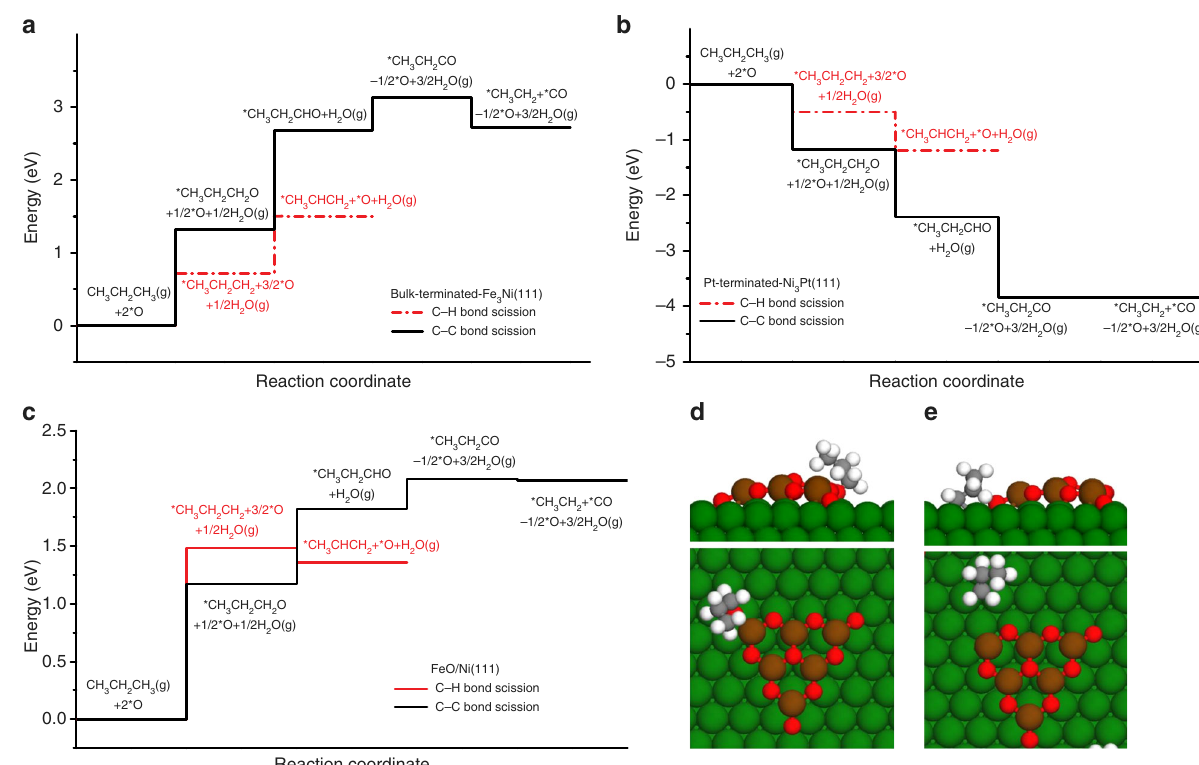
Fig. 4 DFT calculated energy pro fi les for the oxidative C – H and C – C bond scission pathways. a Bulk Fe 3 Ni(111) surface, b Pt-terminated Ni 3 Pt(111) surface, and c FeO/Ni(111) interface as well as the optimized geometries of d CH 3 CH 2 CH 2 O and e CH 3 CH 2 CH 2 on